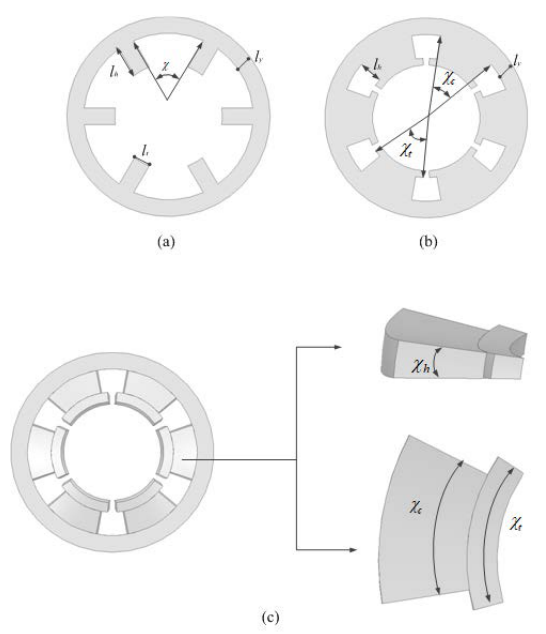
Figure 6. Stator schematic diagram of comparison. ( a ) stator structure before improvement, ( b ) stator structure of 2nd improvement and ( c ) stator structure of 1st or 3rd improvement.